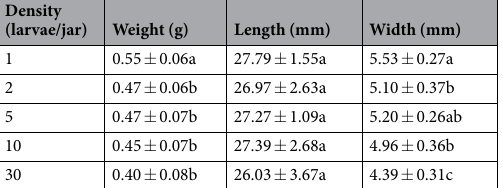
Table 1. Effects of larval density on the sizes and weights of M . separata larvae. Data are presented as the mean ± SE. Within a column, values followed by different letters are significantly different at the 5% level as determined by Duncan’s multiple range test.